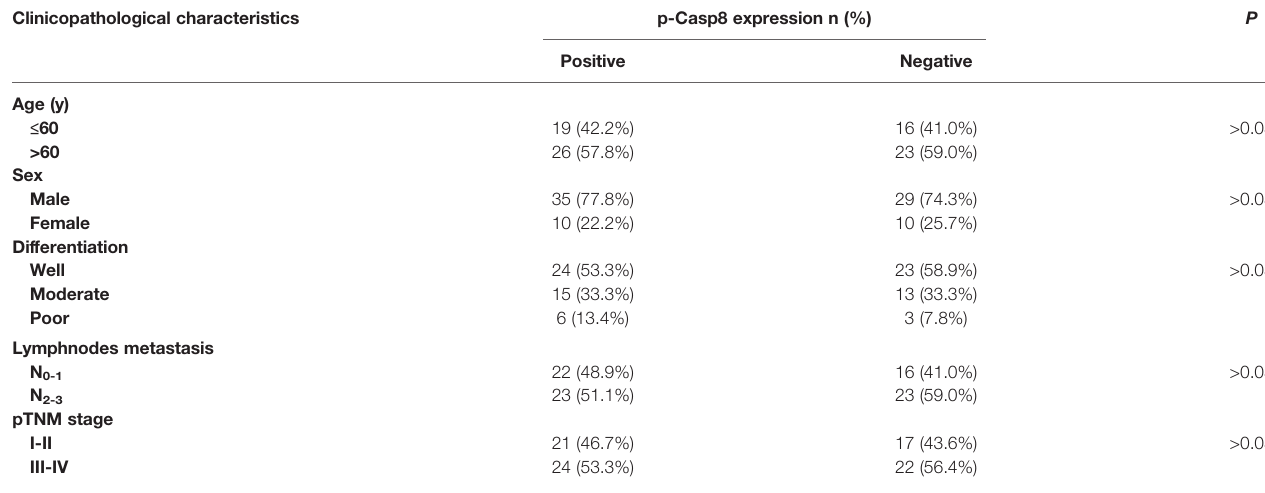
TABLE 1 | Association of phosphotyrosine 380 Caspase-8 (p-Casp8) expression with clinicopathological characteristics of patients with operable lung adenocarcinoma (n = 84). Clinicopathological